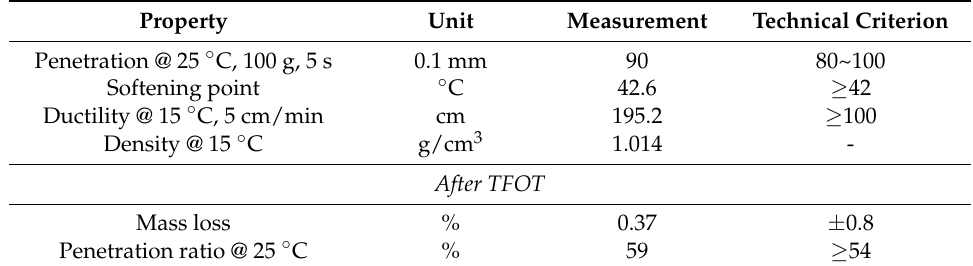
Table 1. Physical properties of base asphalt AH-90.